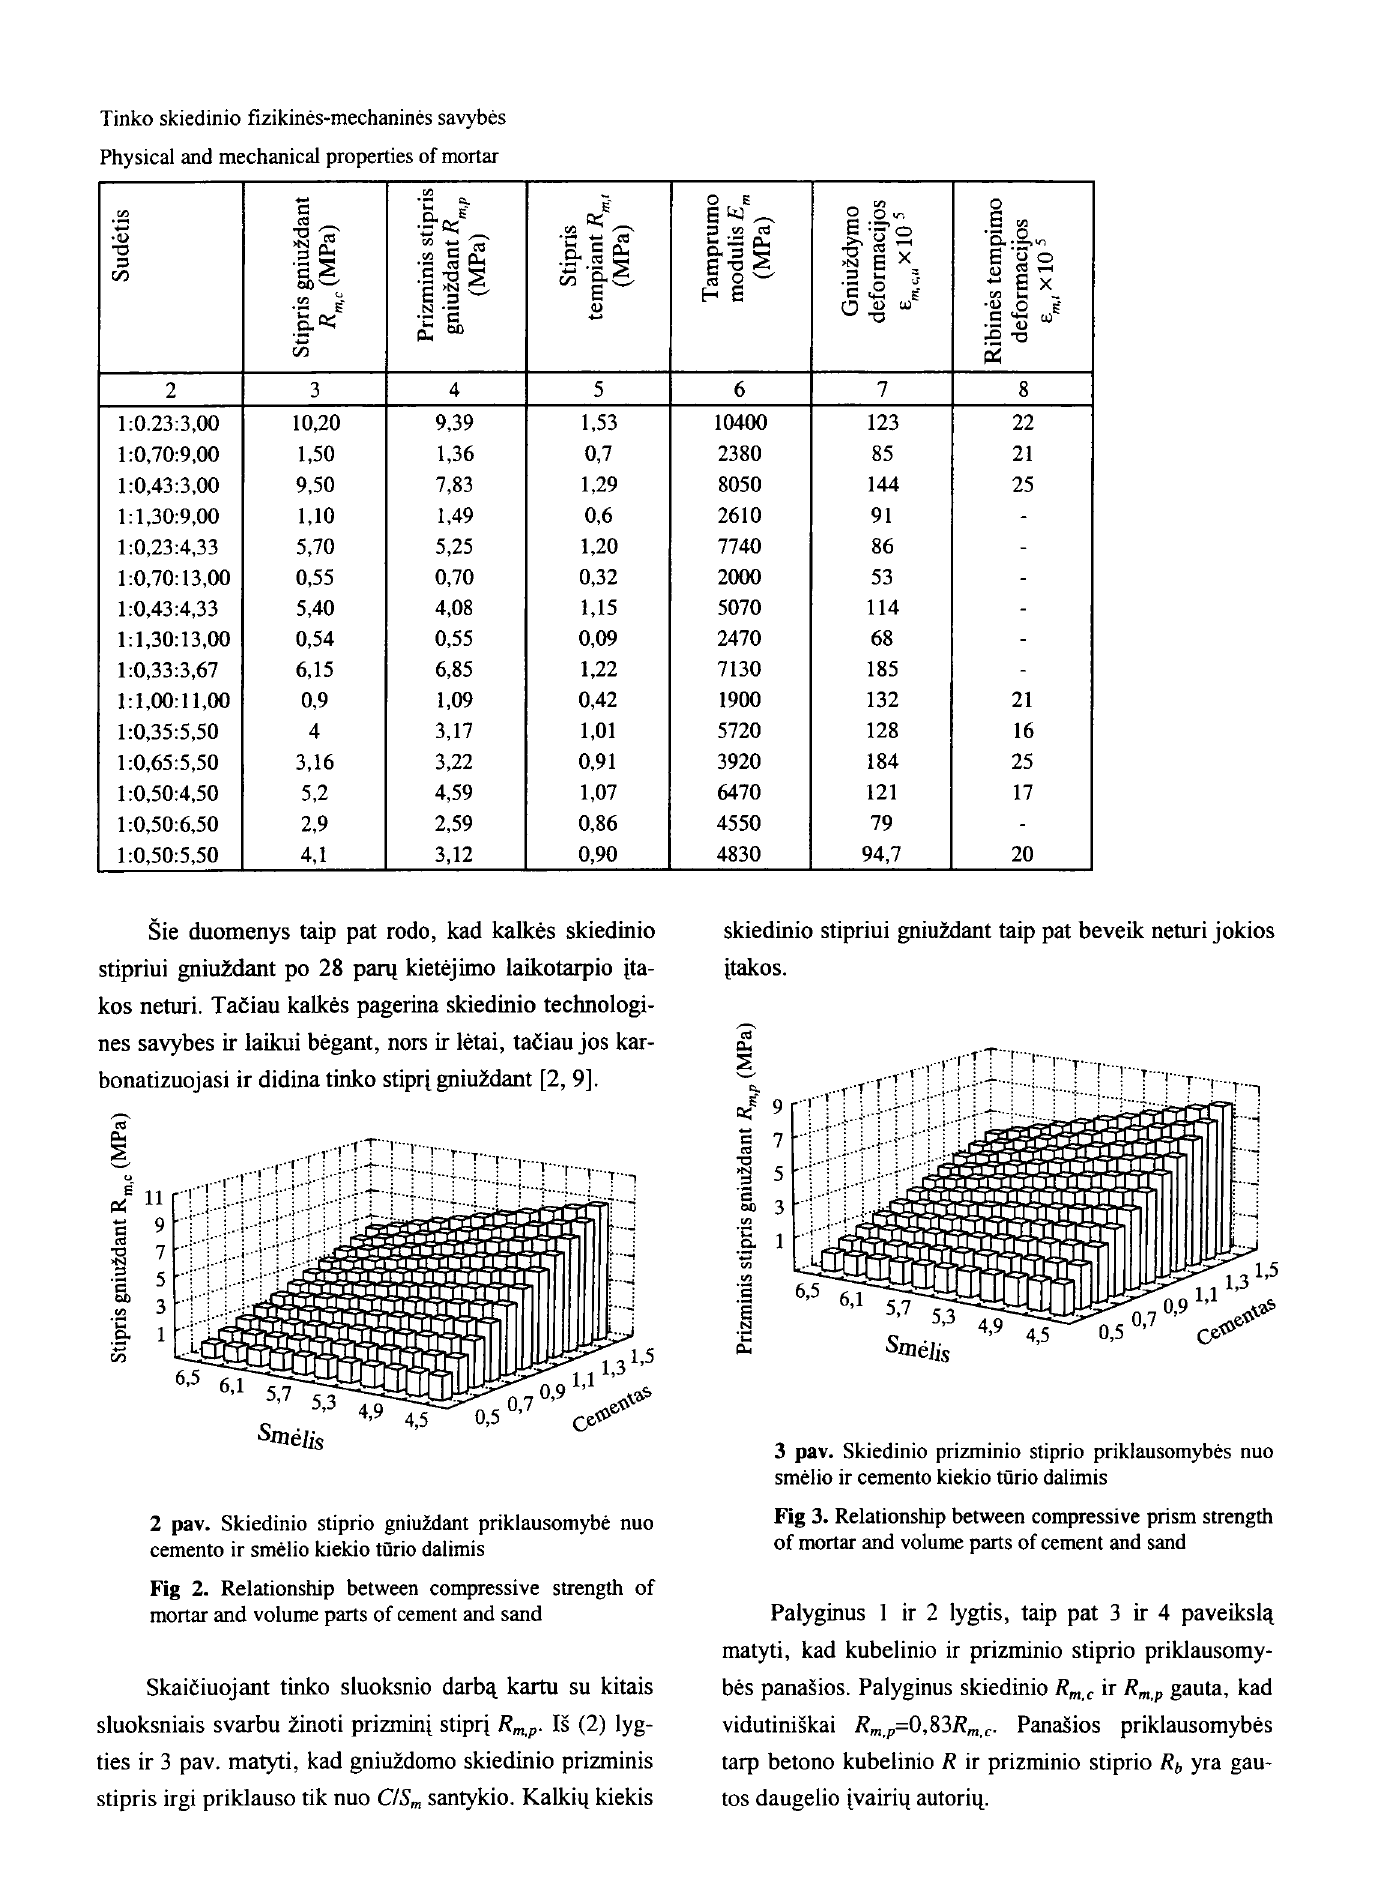
Fig 2. Relationship between compressive strength of mortar and volume parts of cement and sand Skaiciuojant tinko sluoksnio darb~t kartu su kitais sluoksniais svarbu zinoti prizmini stipri Rm.p· IS (2) lyg ties ir 3 pav. matyti, kad gniuzdomo skiedinio prizminis